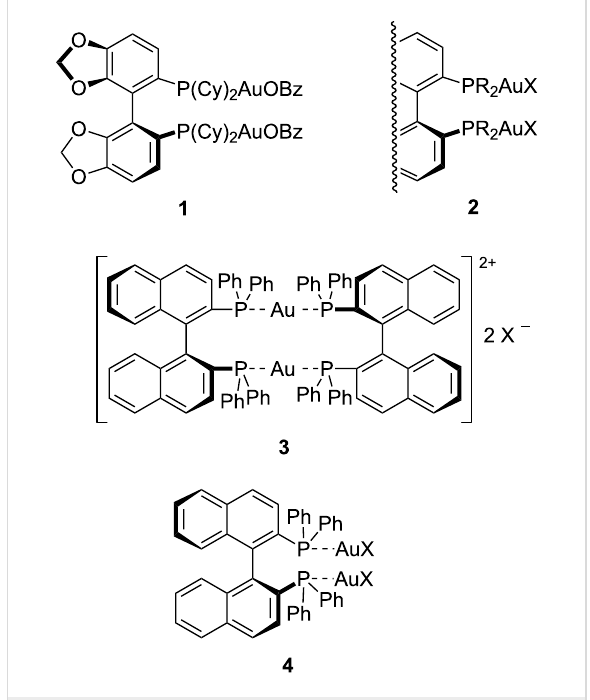
Figure 1: Chiral gold(I) complexes employed in 1,3-DC involving azomethine ylides.